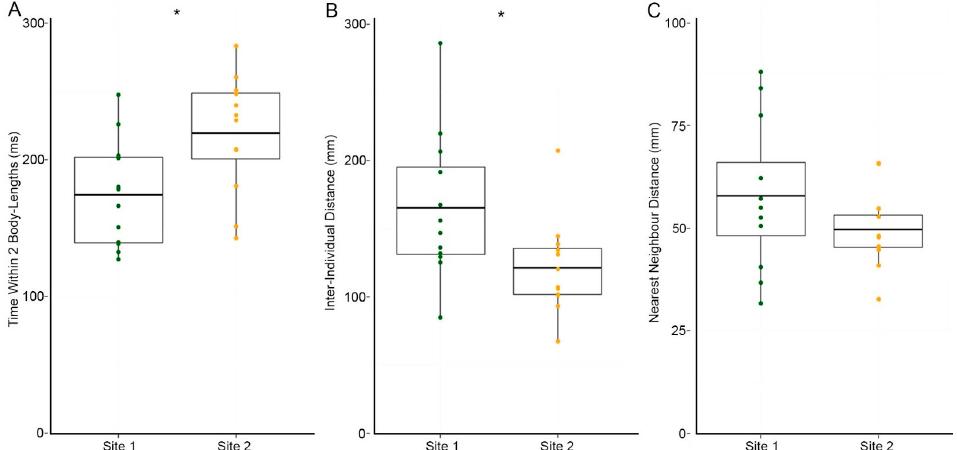
Figure 4. We found that fish from Site 2 were more cohesive than fish from Site 1 across three social metrics. ( A ) Fish from Site 2 spent a greater amount of time within two body-lengths of conspecifics than fish from Site 1. ( B ) Fish from Site 2 maintained closer inter-individual distances between group members, while fish from Site 1 had greater spacing between individuals. ( C ) There were no significant differences in distances between individual fish and their nearest neighbors between populations. Individual samples are overlaid onto boxplots. Boxplots denote means and interquartile range. Error bars indicate the range of scores. * p < 0.05. All data analyzed with independent samples t ‐ tests.